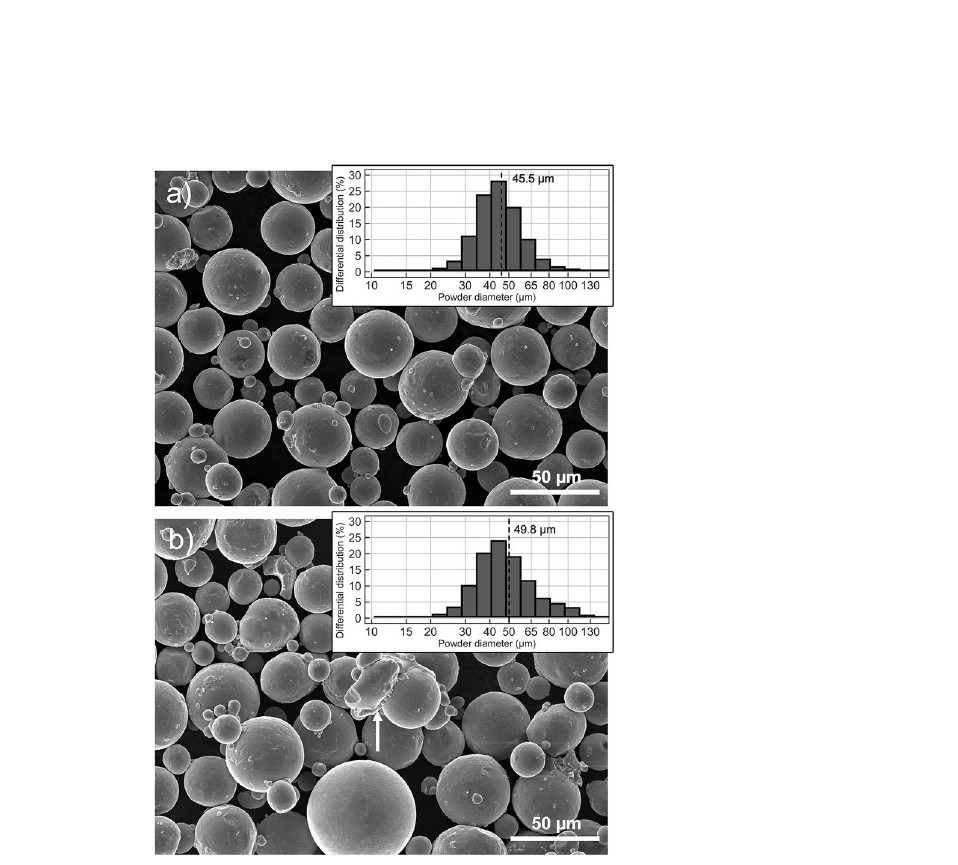
Figure 2. SEM images and particle size distribution of the Ti6Al4V virgin ( a ) and reused ( b )